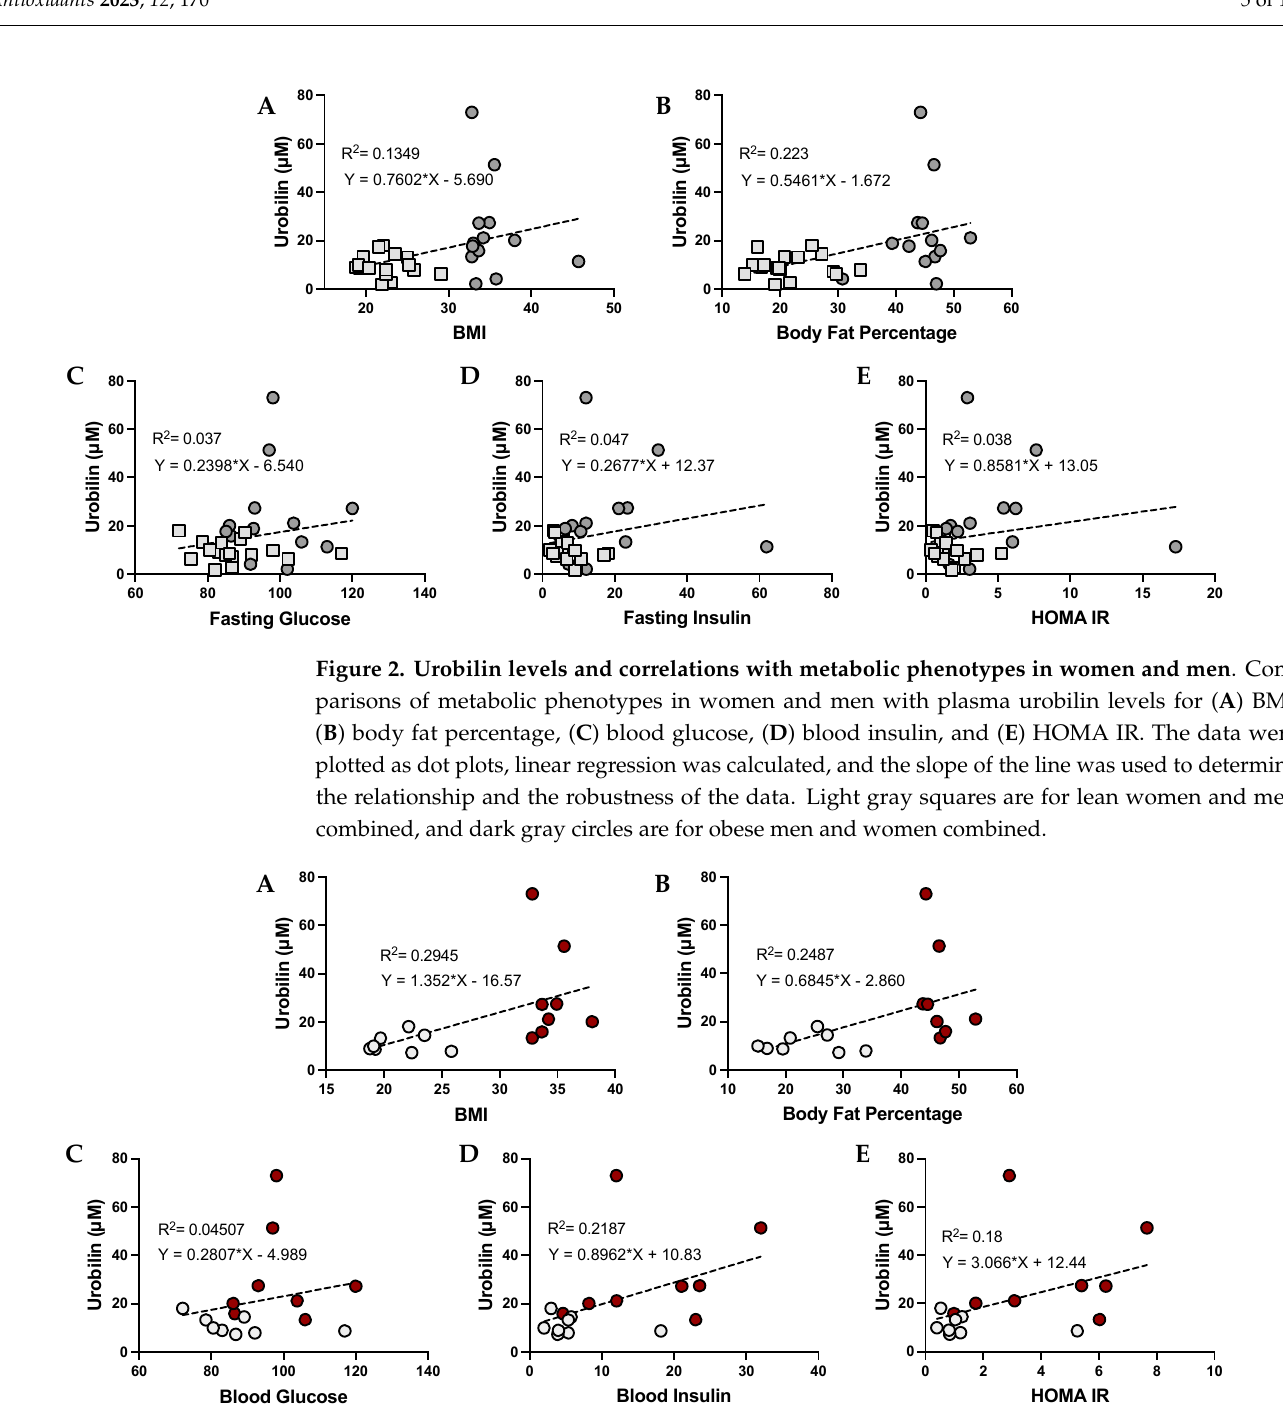
Figure 3. Urobilin levels and correlations with metabolic phenotypes in women . Comparisons of metabolic phenotypes in women with plasma urobilin levels for ( A ) BMI, ( B ) body fat percentage, ( C ) blood glucose, ( D ) blood insulin, and ( E ) HOMA IR. The data were plotted as dot plots, linear regression was calculated, and the slope of the line was used to determine the relationship and the robustness of the data. Red circles are for obese women, and gray circles are for their lean